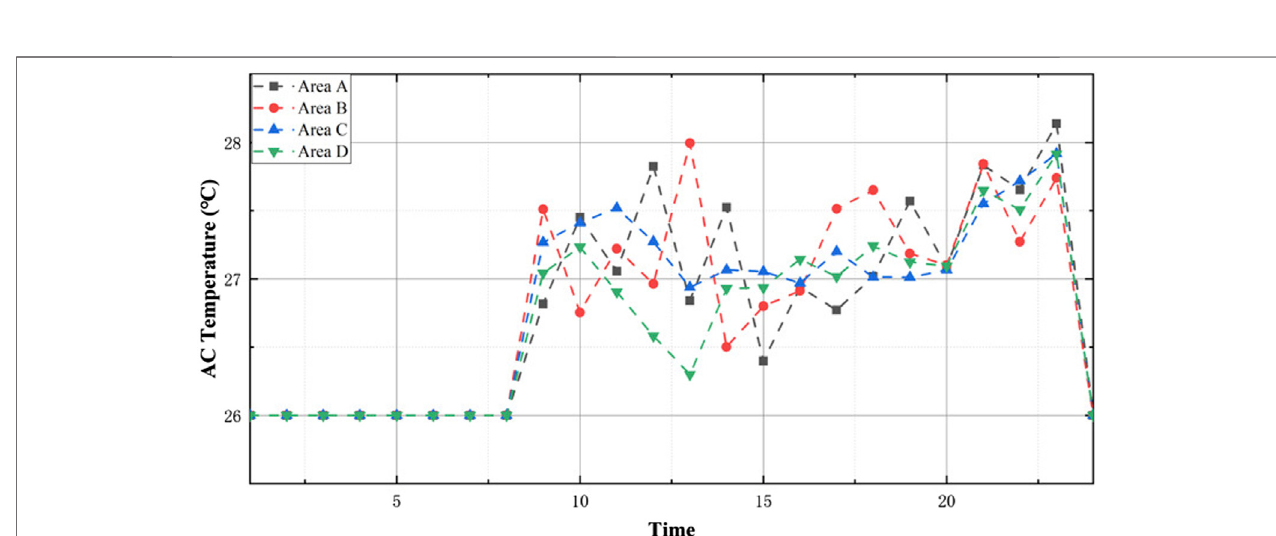
FIGURE 6 | The optimal air-conditioning temperature strategy of passive storage buildings.